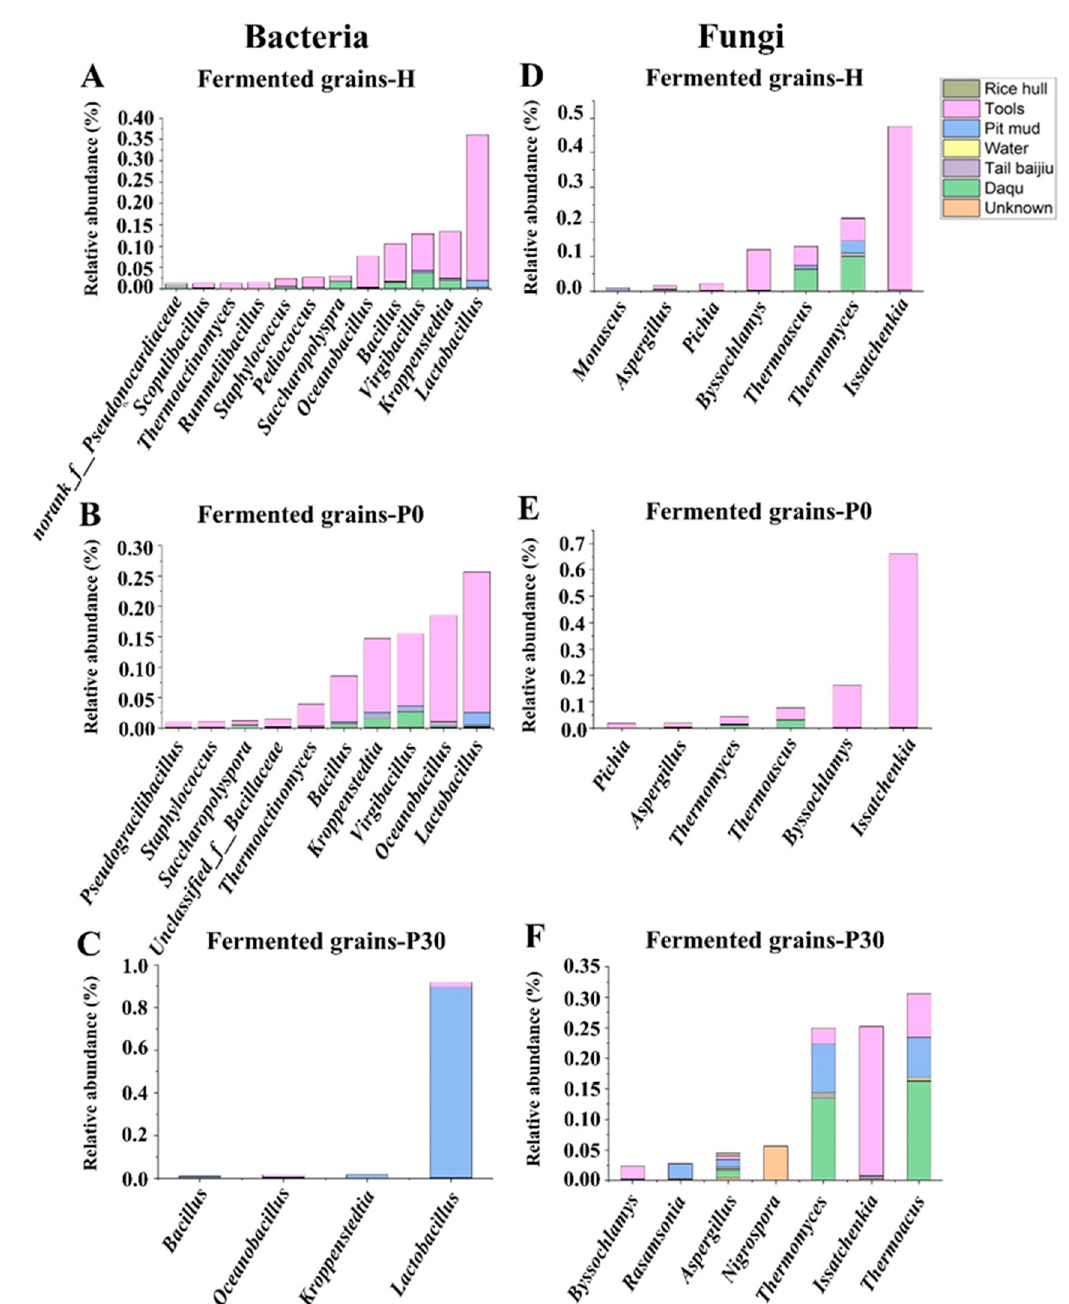
Figure 5. Source-tracking analysis of bacterial genus in fermented grains during the heap fermenta- tion ( A ), beginning ( B ), and end ( C ) of pit fermentation. Source-tracking analysis of fungal genus in fermented grains during the heap fermentation ( D ), beginning ( E ), and end ( F ) of pit fermentation.